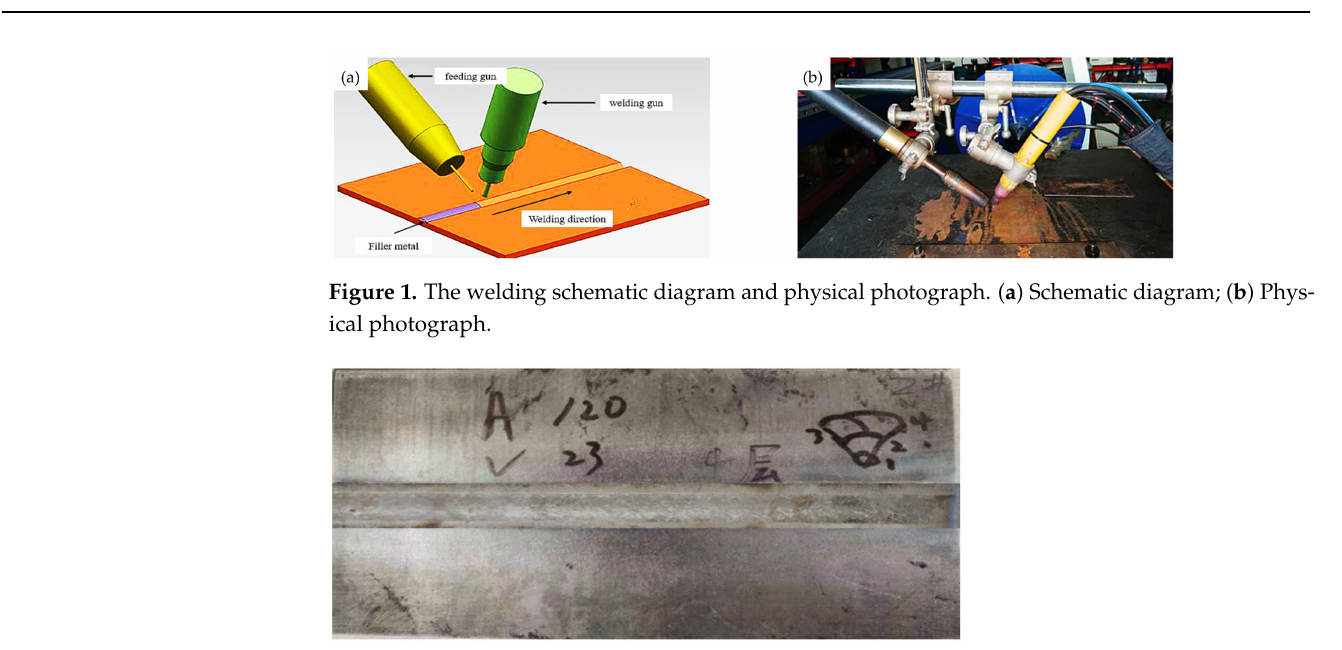
Figure 2. Appearance of the weld seam.